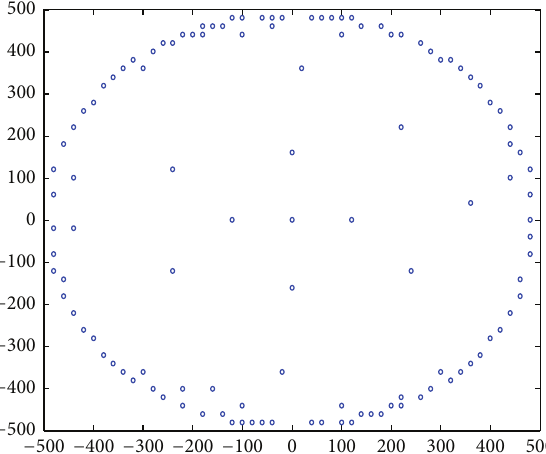
Figure 36: Mobile sink positions in distributed algorithm.